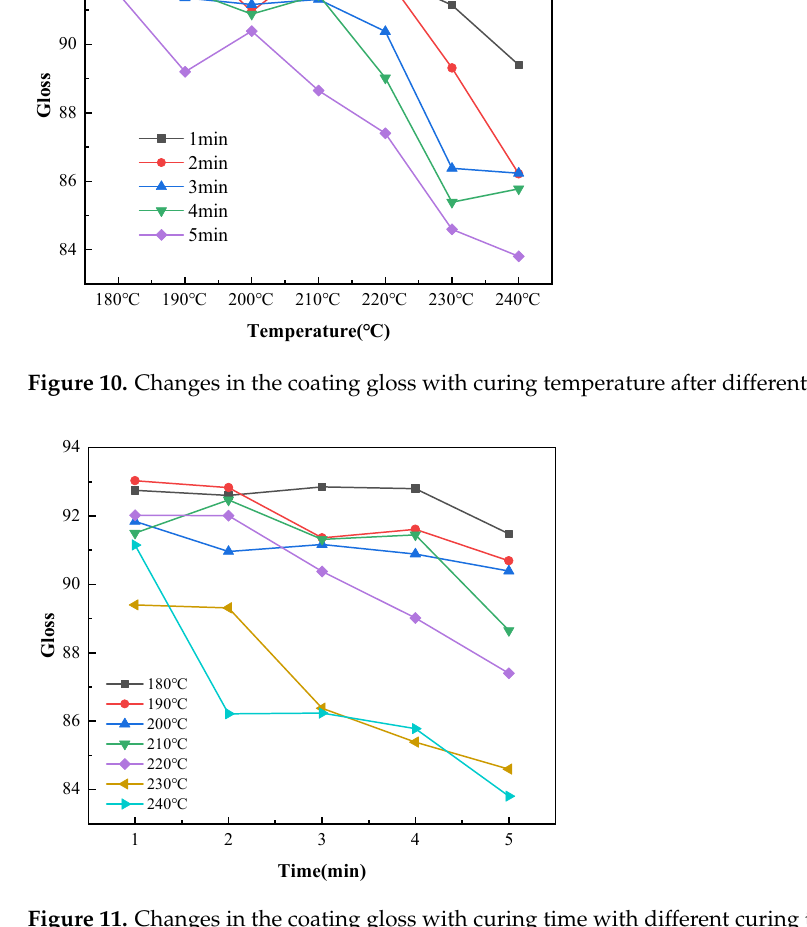
Figure 11. Changes in the coating gloss with curing time with different curing temperatures.